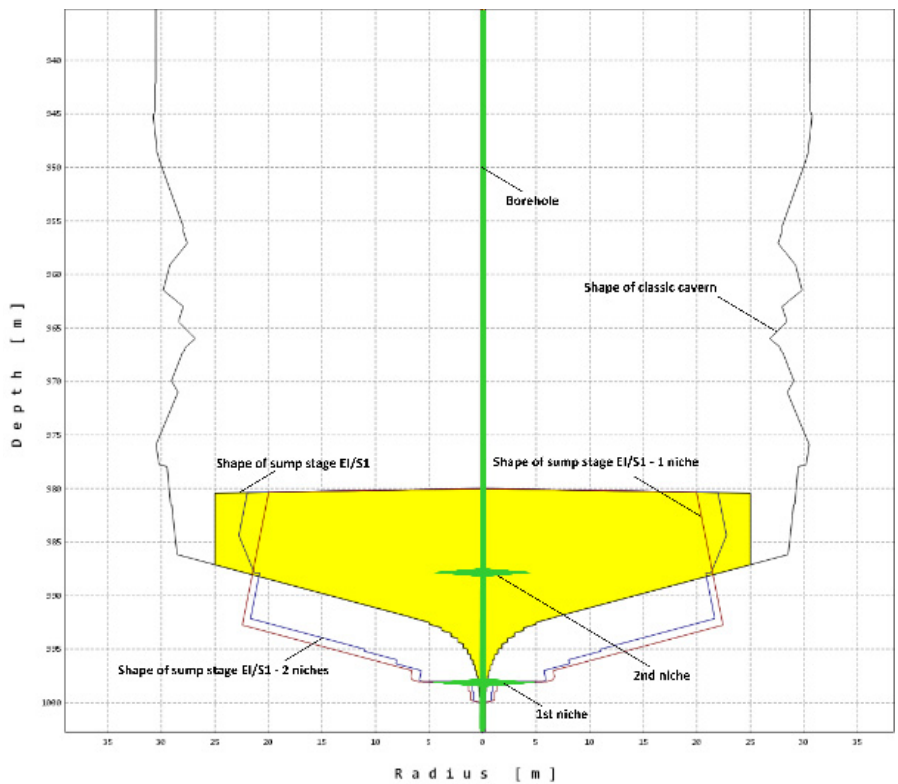
Figure 7. Comparison of the sumps’ shapes for scenarios on the basis of a classic storage cavern.